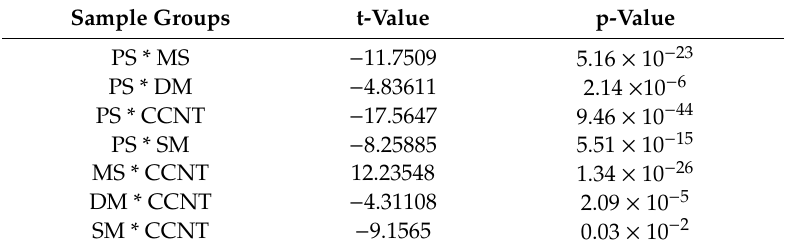
Table 5. Statistical parameter for sample groups of di ff erent dispersion